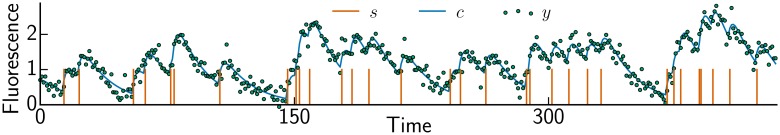
Generative autoregessive model for calcium dynamics.Spike train s gets filtered to produce calcium trace c; here we used p = 2 as order of the AR process. Added noise yields the observed fluorescence y.